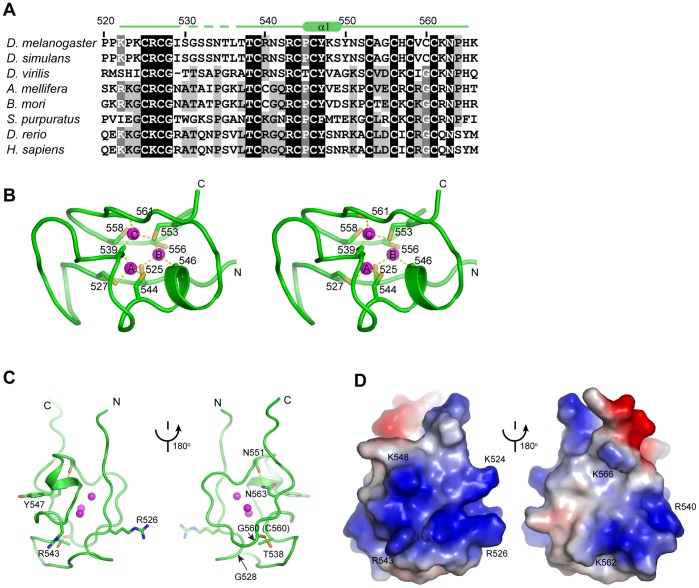
Important features of MSL2 CXC domain structure.(A) Sequence alignment of MSL2 homologs in the CXC domain. A total of 44 sequences were aligned and eight sequences are displayed. Residues conserved in 98%, 80% and 60% of 44 aligned sequences are shaded in black, gray and light gray, respectively. Similar amino acid groups are defined as follows: D and E; S and T; K and R; F, Y and W; L, I, V and M. The secondary structures are shown on the top with dotted line representing mobile regions. (B) Structure of the Zn3Cys9 cluster in cross-eye stereoview. The Zn-S coordination bonds are shown as dotted lines. (C) The highly conserved non-Cys residues of MSL2 CXC domain are displayed in sticks. Two views related by a 180° rotation are shown and dotted lines denote hydrogen bonds. (D) The electrostatic potential surface is colored from red to blue for negatively to positively charged regions. The structure is shown in the same two orientations as in (C).